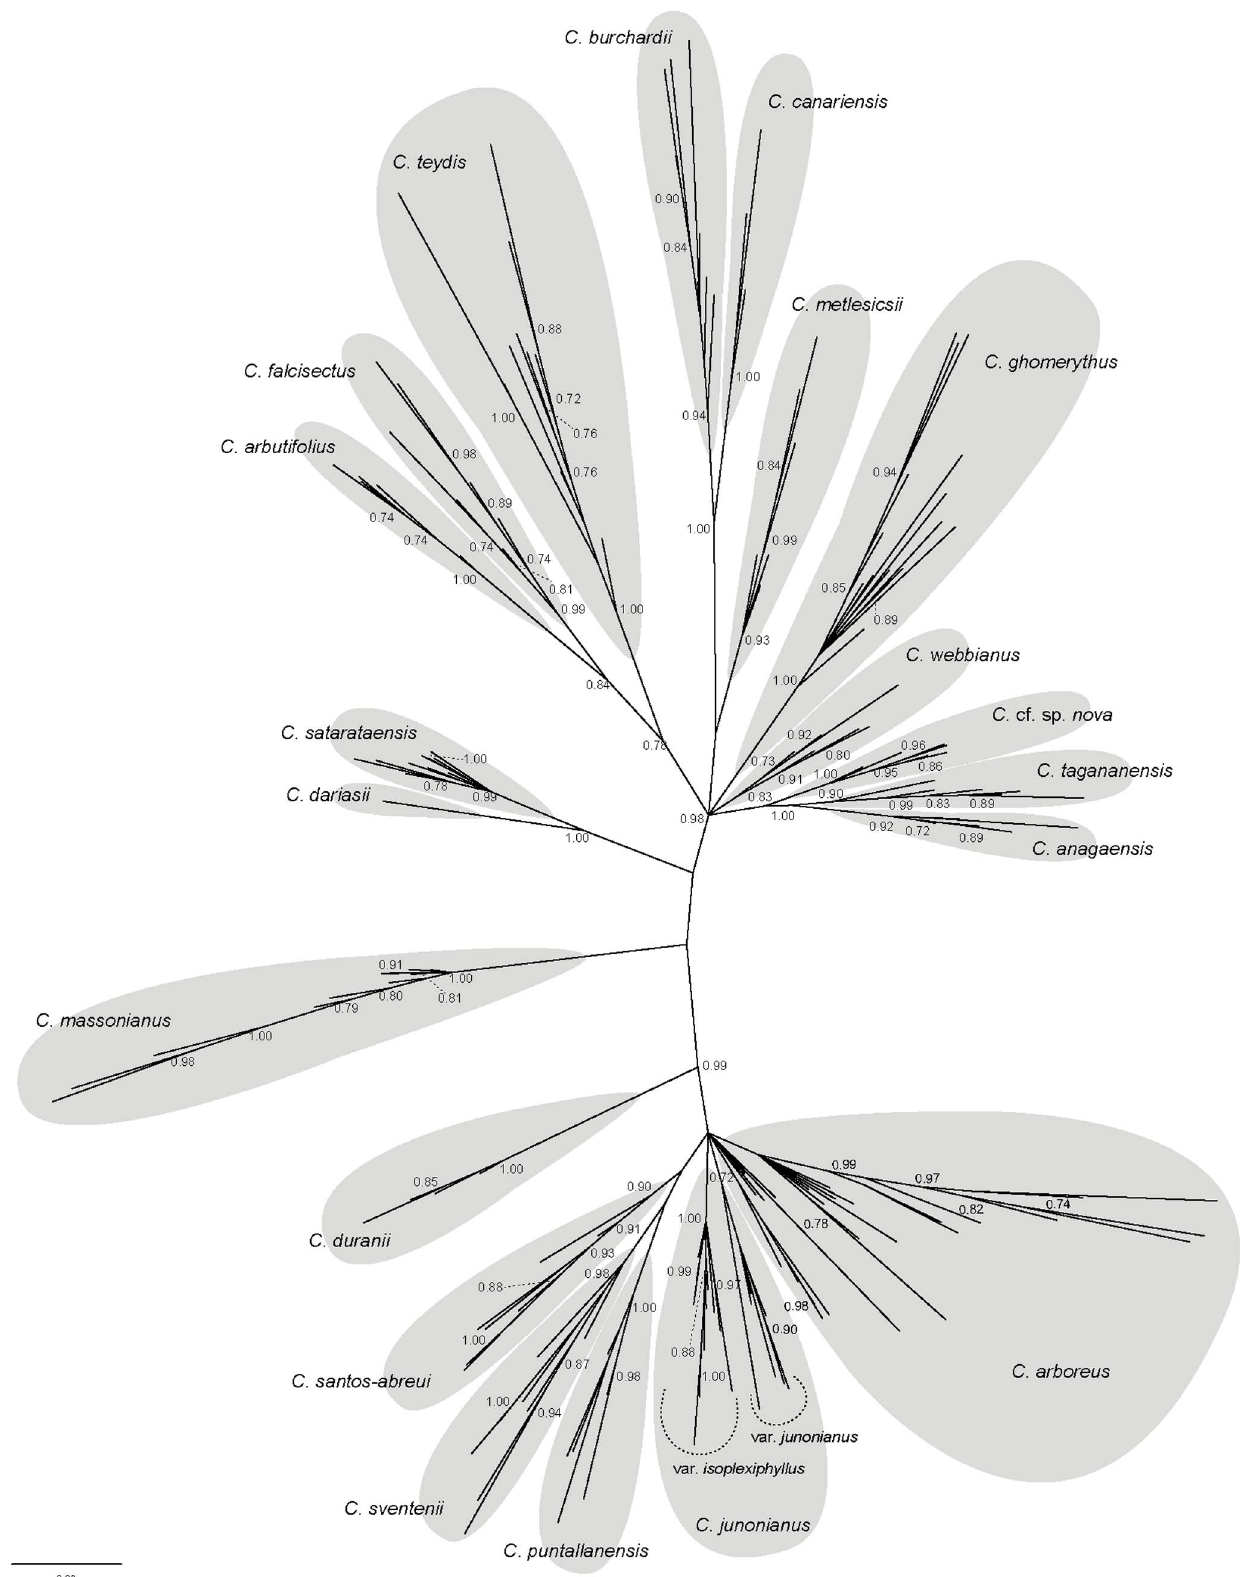
Figure 2. Phylogenetic analysis of AFLP data. Unrooted 50% majority rule tree from Bayesian analysis of the combined AFLP dataset for all Macaronesian species of Cheirolophus . Posterior probability values $ 70 are shown near each branch.